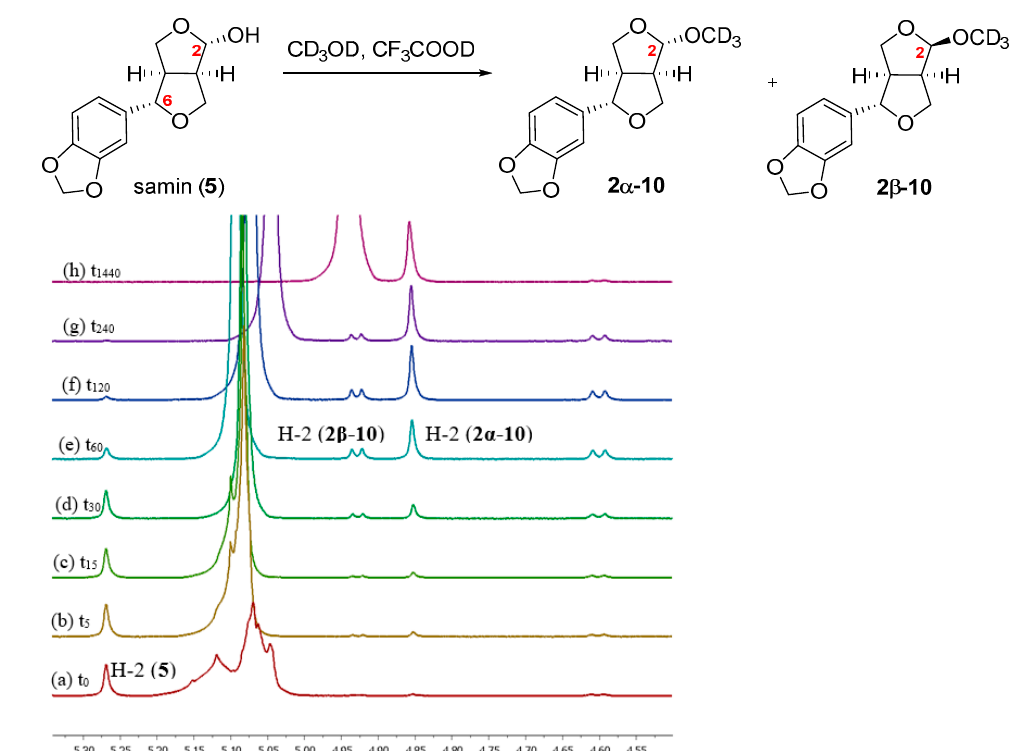
Figure 5. Overlaid 1 H NMR spectra of the nucleophilic substitution reaction of samin for different times.